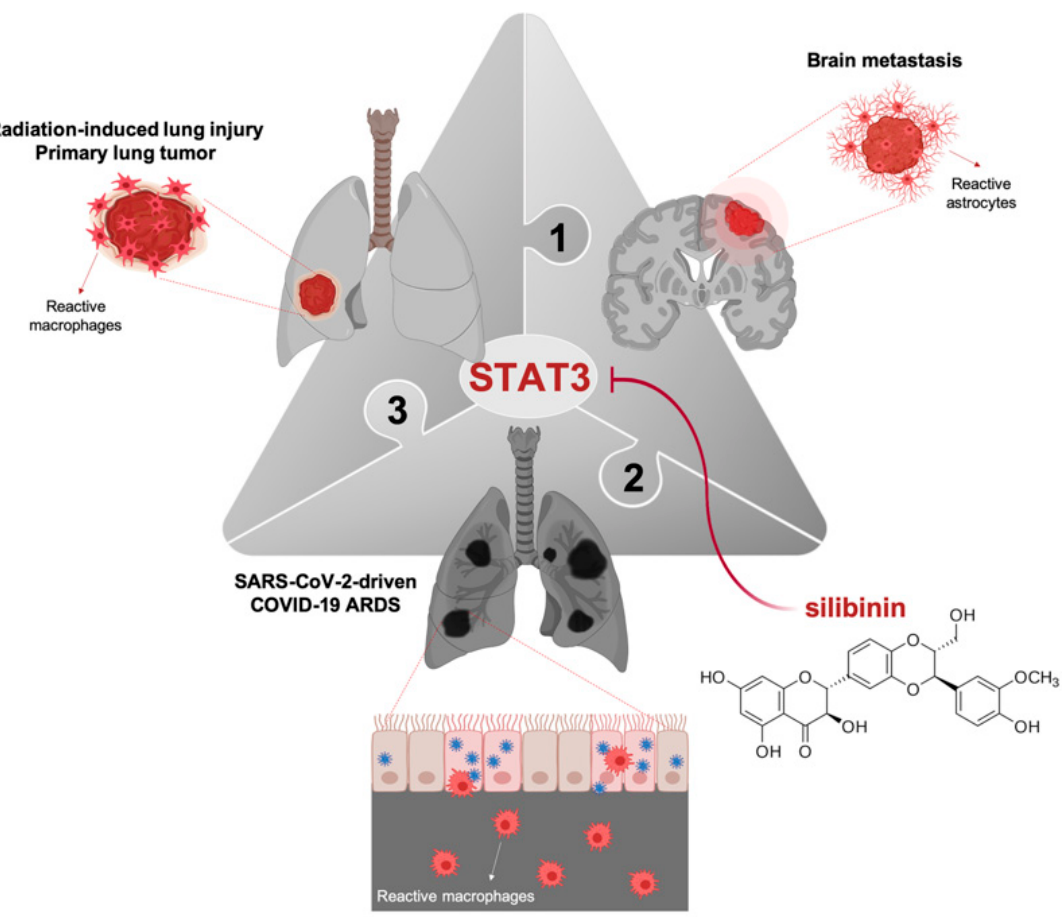
Figure 1. Silibinin as a direct STAT3 inhibitor: regulating the response intensity of reactive reparative cells to damaged tissues. STAT3 is a master checkpoint regulator of the interface between cytokines, inflammation, and immune response against various types of tissue damage including viral infections. By operating as a direct inhibitor of STAT3, silibinin regulates the response intensity of reparative cells (e.g., macrophages, astrocytes) to damaged tissues (e.g., radiation-induced lung injury, primary lung tumor, brain metastasis). In the ongoing scenario of the 2019—2020 SARS-CoV-2 pandemic, in which the futile accumulation of inflammatory macrophages in lungs as the main source of pro-inflammatory cytokines associates with fatal disease in a subgroup of severe COVID-19 patients fully meeting acute respiratory distress syndrome (ARDS) criteria, targeted antagonism of STAT3 with silibinin might ameliorate COVID-19 morbidity and mortality.